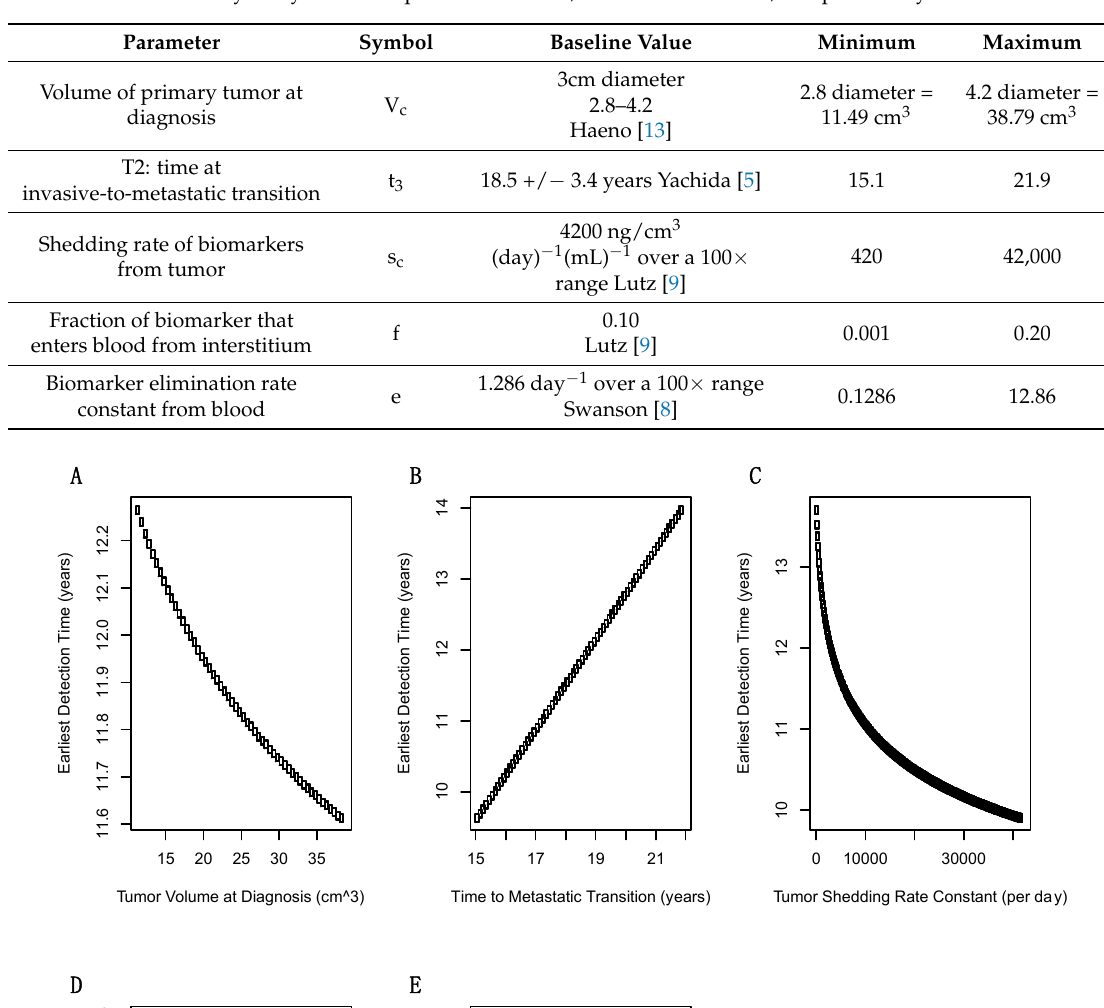
Table 3. Sensitivity analysis: model parameter means, standard deviations, and probability distributions.